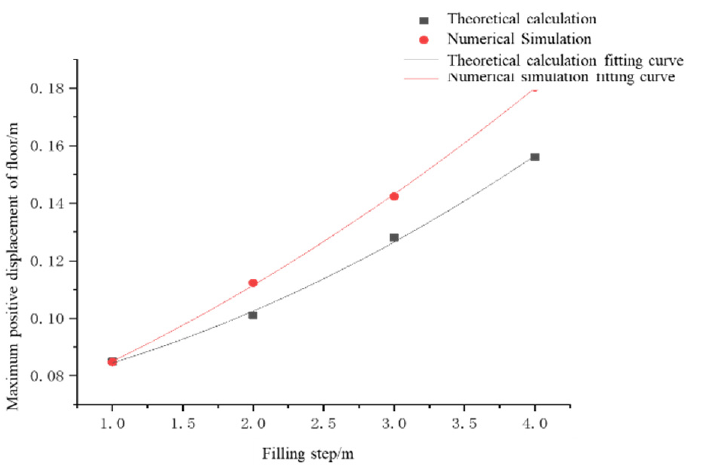
Figure 12. The relationship between different filling steps and the maximum positive displacement of the